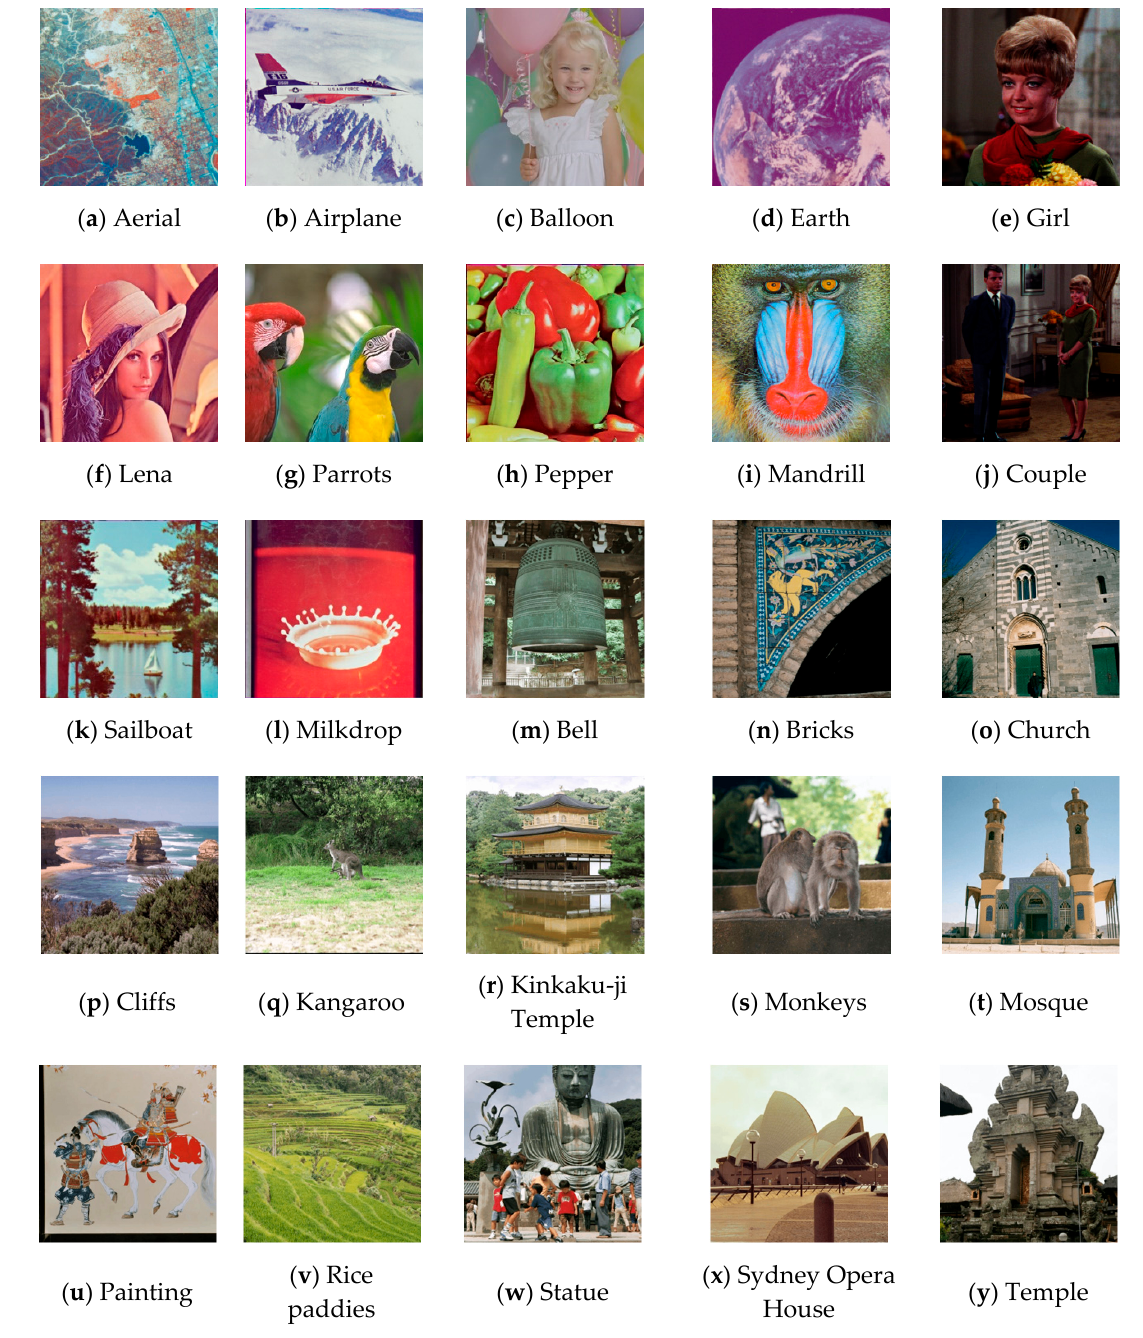
Figure 1. Twenty ‐ five test images. Figure 1. Twenty-five test